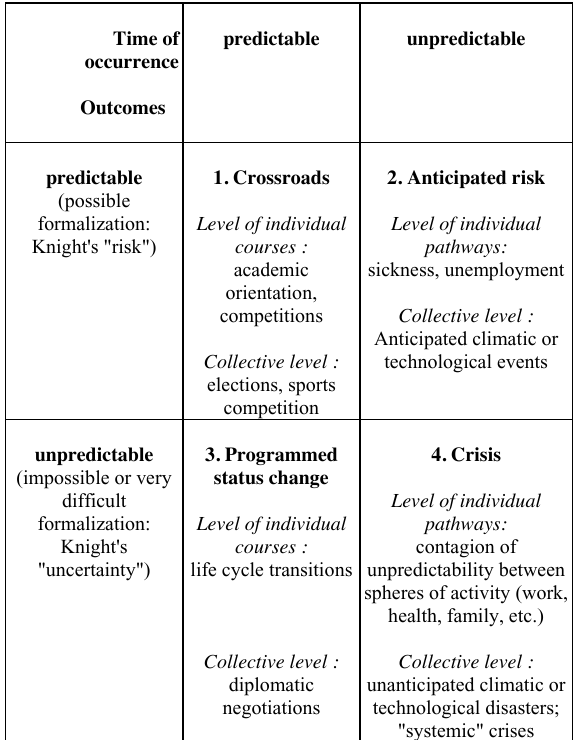
Table 1. Forms of predictability of social